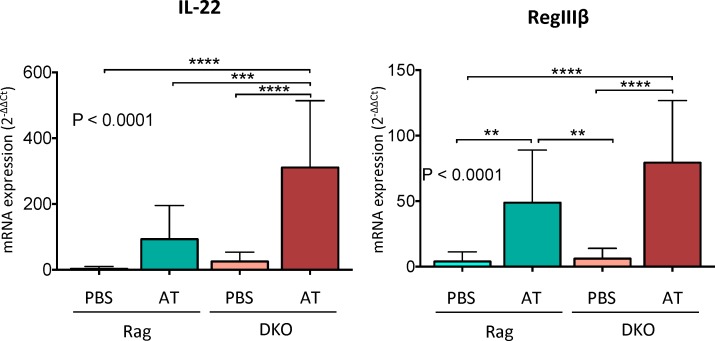
Mucosal expression of protective cytokine IL-22 and IL-22-regulated antimicrobial peptide, RegIIIβ.Bars represent mean values ± SD. Statistical analysis were performed using one-way ANOVA (P value indicated in each panel) with Fisher’s LSD post-hoc test. Asterics in all panels indicate statistical significance: ** P < 0.01, *** P< 0.001, **** P < 0.0001.